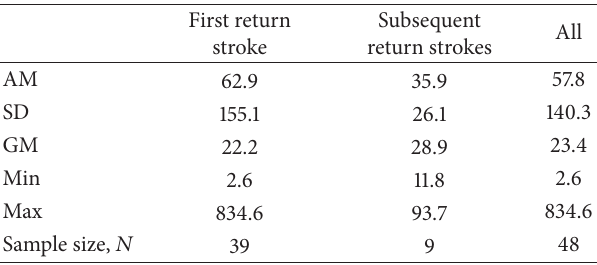
Table 5: Statistical summary of zero-crossing